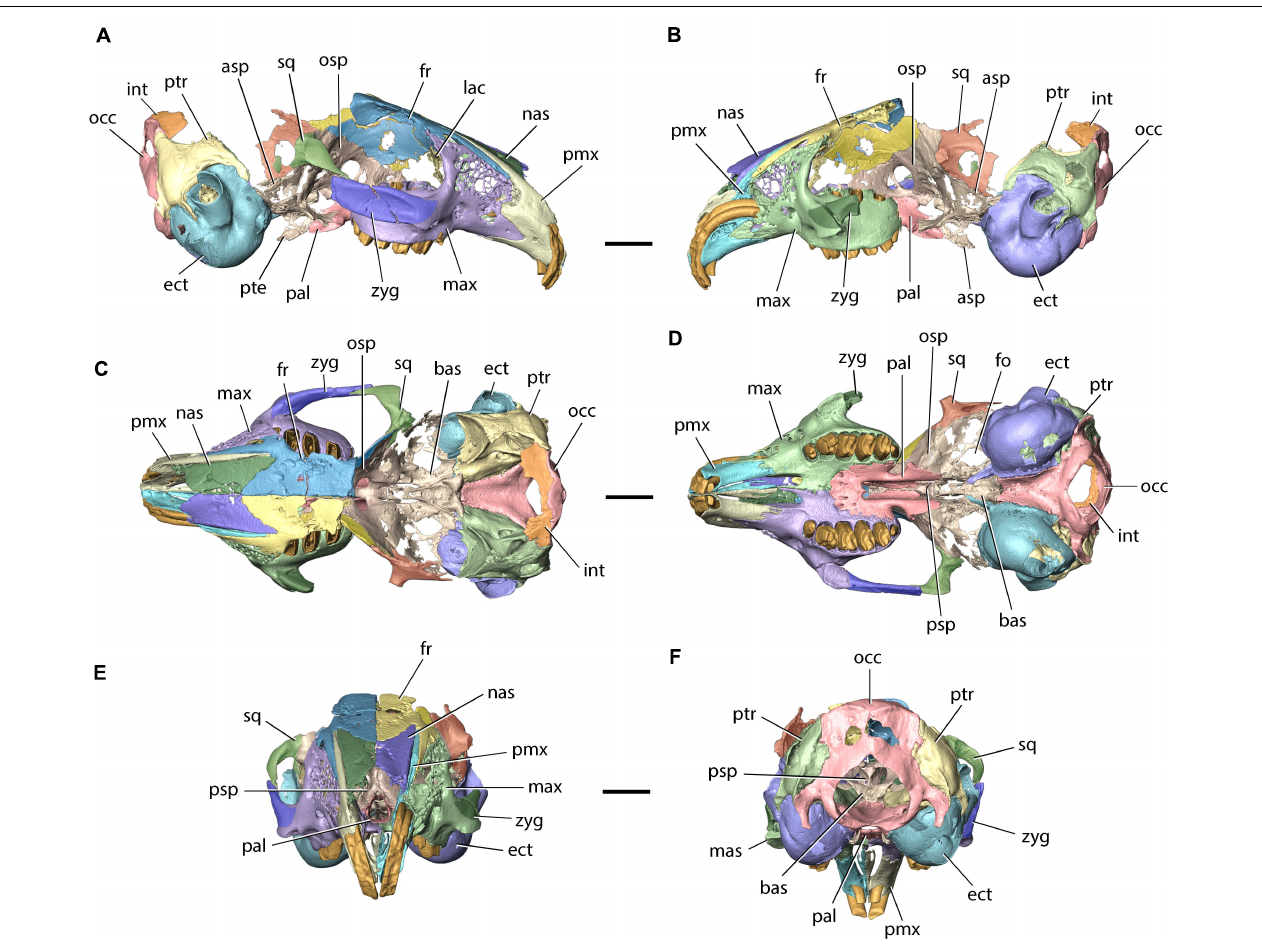
FIGURE 3 | Model of the cranium of Palaeolagus haydeni (FMNH PM9476) in (A) left lateral, (B) right lateral, (C) dorsal, (D) ventral, (E) anterior, and (F) posterior views. asp, alisphenoid; bas, basisphenoid; ect, ectotympanic; fo, foramen ovale; fr, frontal; int, interparietal; lac, lacrimal; mas, masseteric spine; max, maxilla; nas, nasal; occ, occipital; osp, orbitosphenoid; pal, palatine; pmx, premaxilla; psp, presphenoid; pte, pterygoid; ptr, petrosal; sq, squamosal; zyg, zygomatic. Scale bars = 10